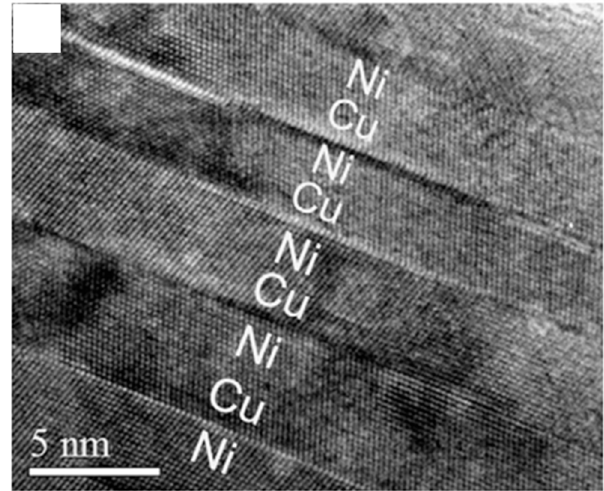
Figure 1. HRTEM image of full coherent interfaces [17].